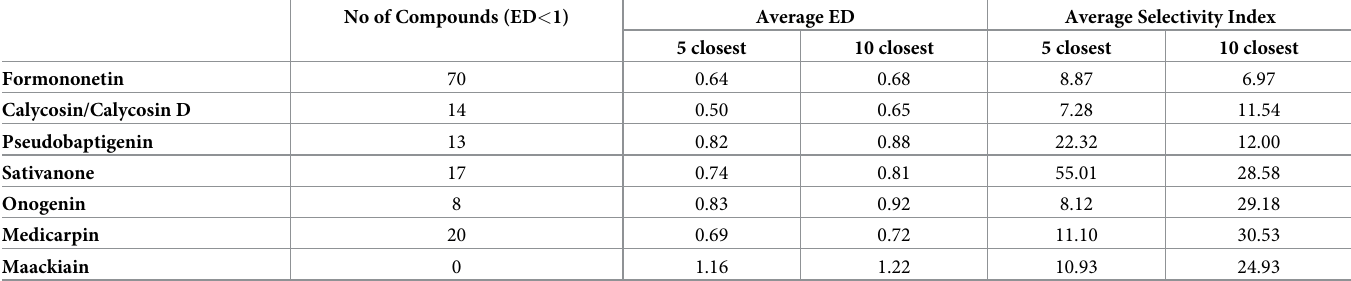
Table 4. The number of compounds in the proximity of the target molecules, and the average MAO-B inhibitory selectivity indices of the 10 and 5 closest structures in chemical space (see details in